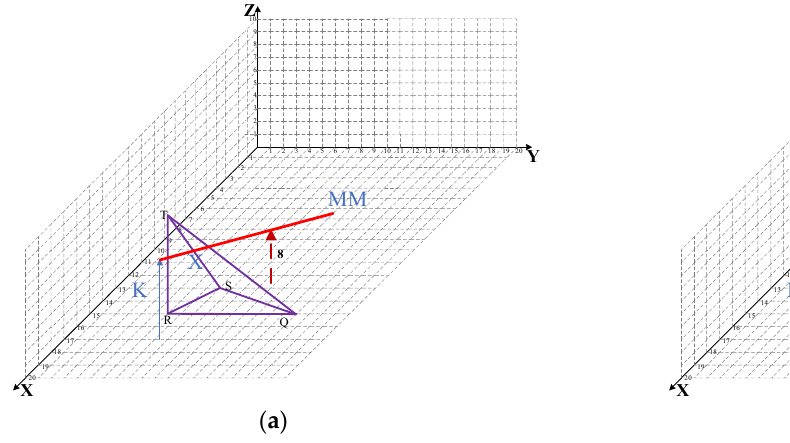
Figure 4. Environment occlusion in 2-D.